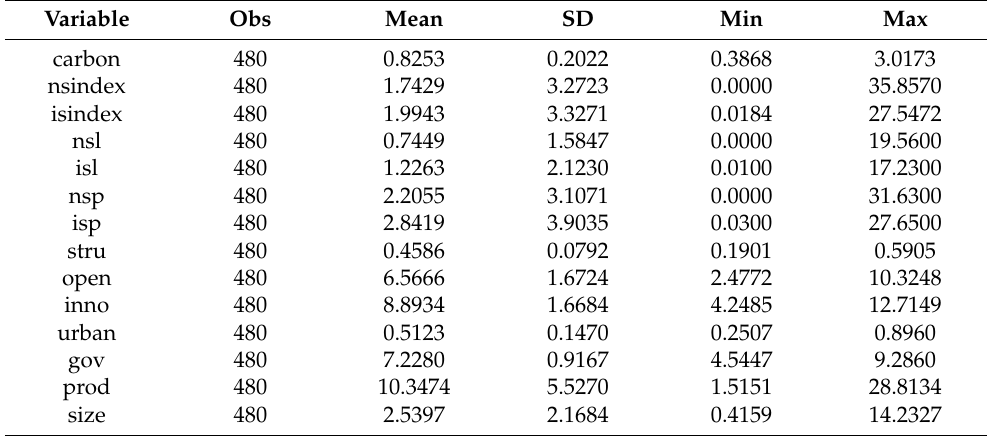
Table 1. Overview of the variables used in the